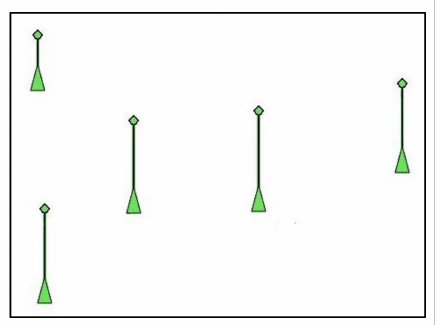
Figure 16. Template with five false AIS plots randomly distributed.